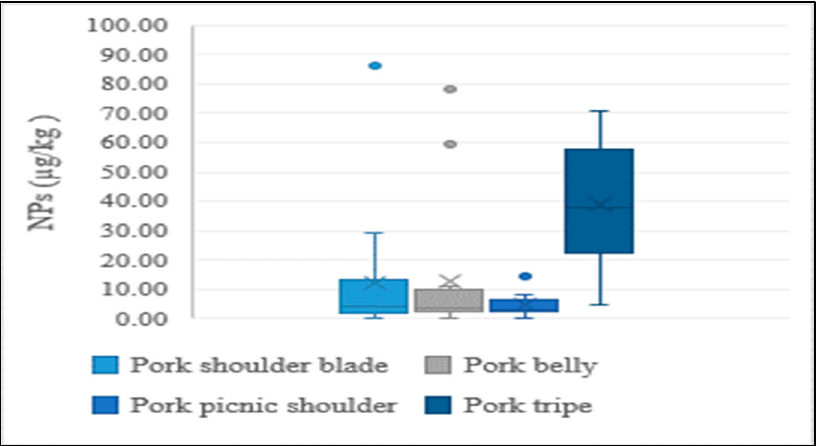
Figure 5. Average concentration of NPs in different edible parts of pork.